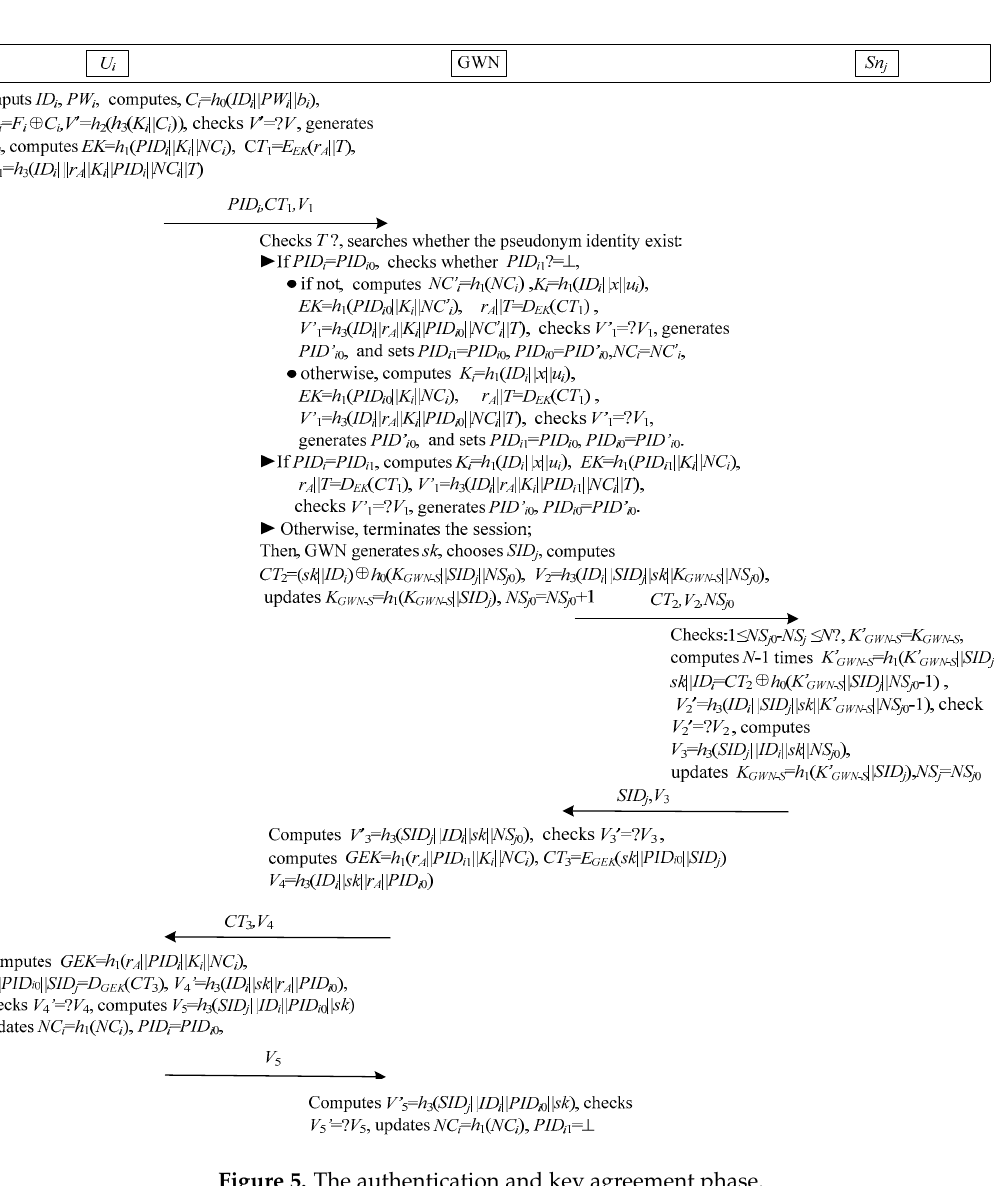
Figure 5. The authentication and key agreement phase